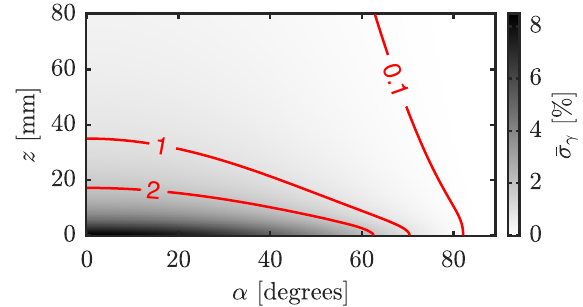
FIG. 11. Energy spread increase as a function of reflector angle and drift distance from the exit of a 5 GeVaccelerator operating in the highly nonlinear regime with a 0 ¼ 5